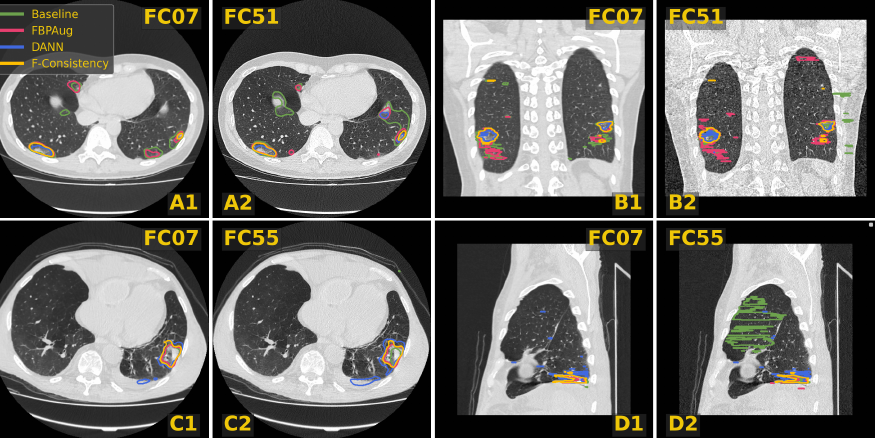
Figure 3. Examples of CT slices from the Private-paired dataset with the corresponding predictions on the paired images. Four doublets, denoted ( A – D ), contain corresponding slices from the smooth and sharp images. The doublets B and D are coronal and sagittal slices, respectively. Every slice contains predictions of four methods named in the